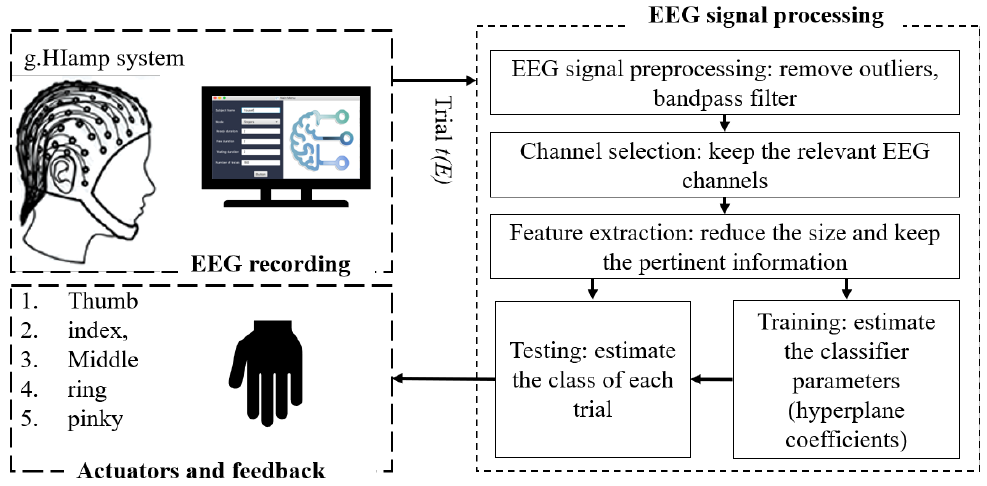
Figure 1. General structure of the proposed